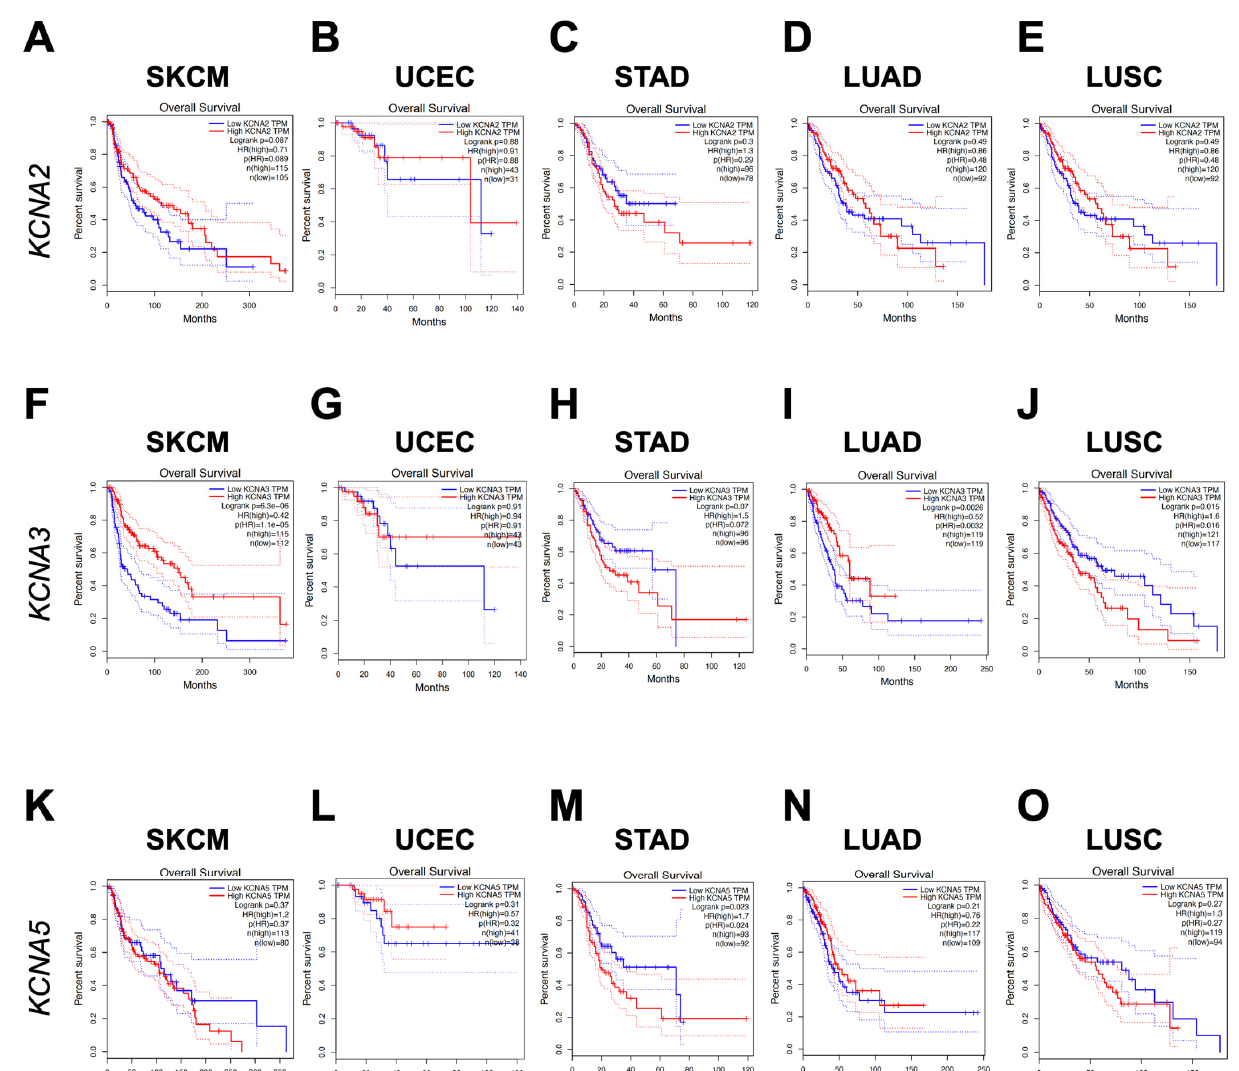
Figure 2. Kaplan–Meier curves based on KCNAs expression in patients. Survival plots based on KCNA2 ( A – E ), KCNA3 ( F – J ), and KCNA5 ( K – O ) expression level in represented tumours were obtained through Kaplan–Meier analysis by sorting samples for high and low KCNA expression groups according to the quartile on GEPIA. The percentage of survival is plotted, and p -values are shown as per figure specifications, respectively.